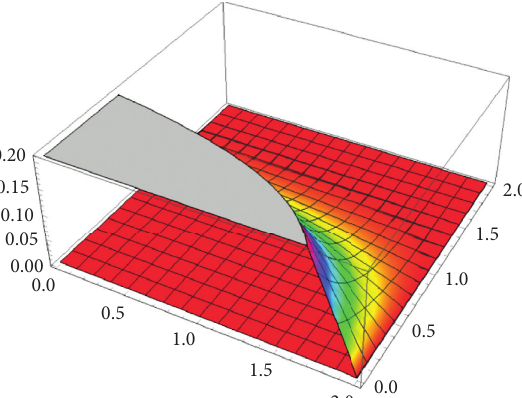
Figure 3: 0 is the common fixed point of H and K